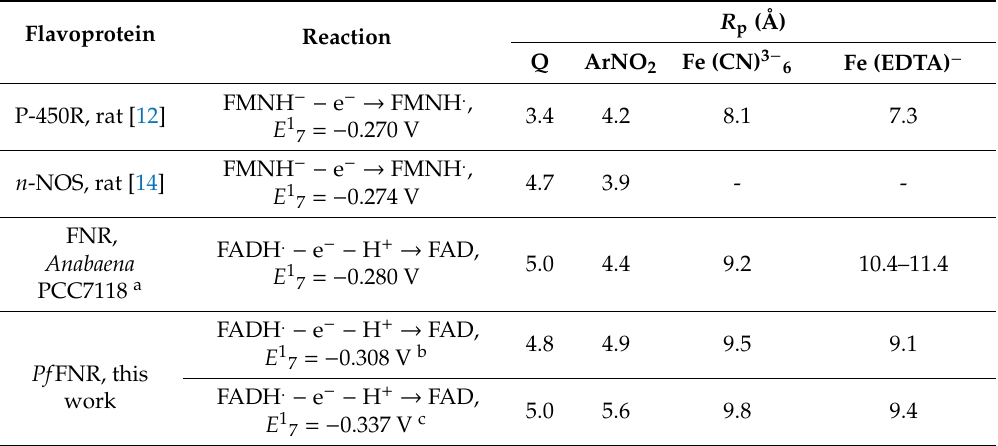
Table 2. Distances of the electron transfer ( R p ) in reactions of flavin-dependent electrontransferases with nonphysiological electron acceptors, calculated according to Equation